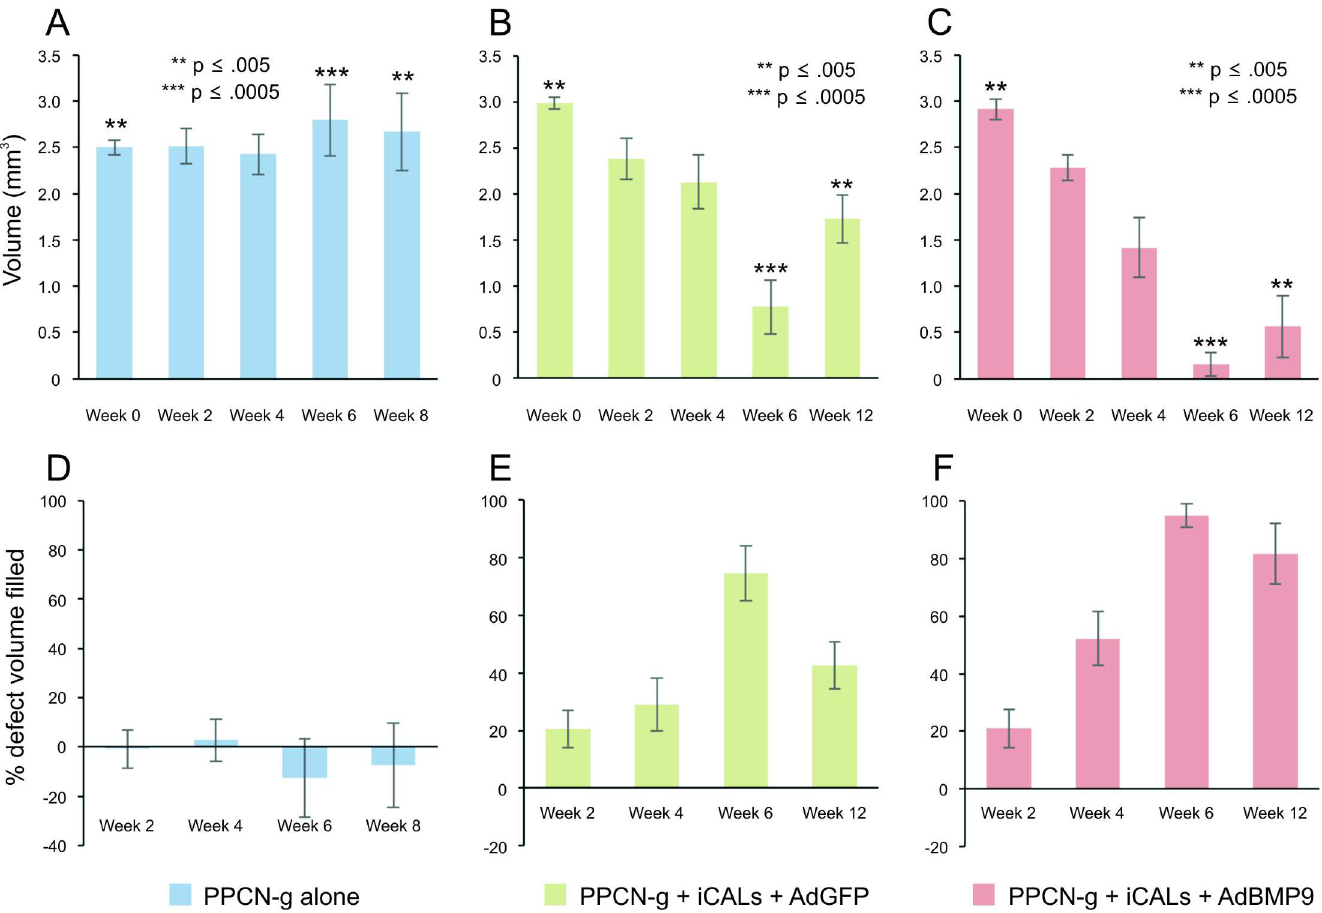
Fig 3. Quantitative analysis of the BMP9-induced calvarial defect repair. (A, B, C) Average defect volumes (mm 3 ) were calculatedat 24–48 hours, 2, 4, 6, 8, and 12 weeks postoperatively using volumetricreconstructions generatedin Amira ® . Asterisks indicate a significant(p < 0.05) difference in averagedefect volume betweentest groups at the specifiedtime point, as determined by one-wayANOVA. (D, E, F) The changein defect volume over time was used to deduce the percentage of baselinedefect volume filled with new bone.